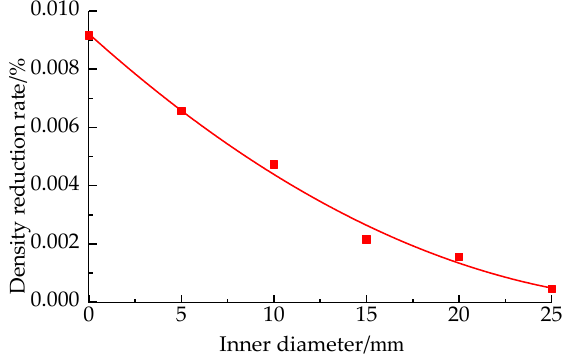
Figure 5. The density reduction rate varies with annular diameter change.